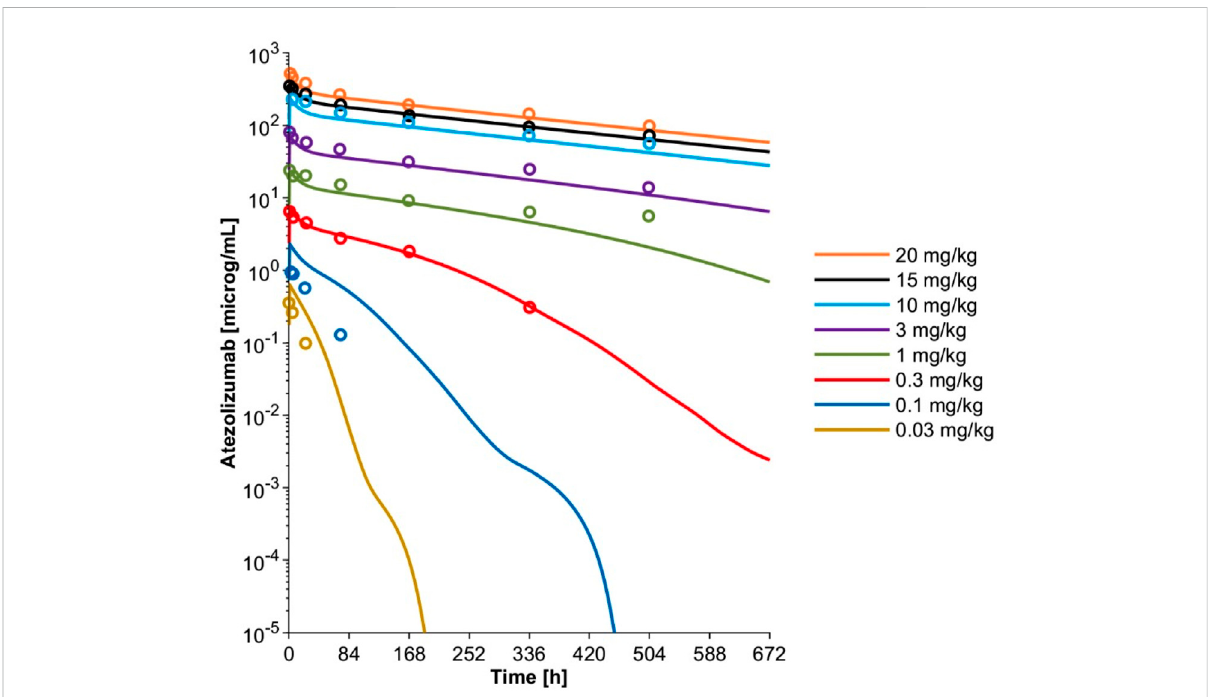
FIGURE 3 Simulated mean plasma concentration-time pro fi les and observed mean concentration data for adult patients with solid tumors and hematologic malignancies after a single IV dose at varying dose levels using the optimized fi nal PBPK model including TMDD. Observed mean data are shown as open circles (Herbst et al., 2014). Simulated mean data are shown as solid